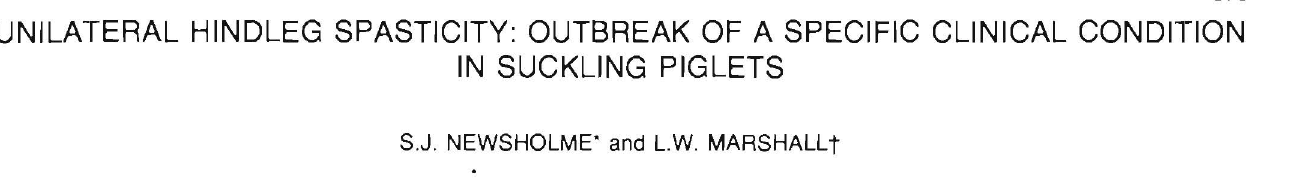
FIg. 1. Piglet A, showing position of hindquarters and ex tension of right hindleg.